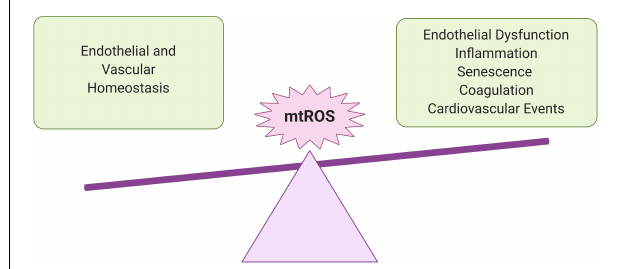
FIGURE 2 | Importance of redox balance in ECs. Understanding the potential impact of SARS-CoV-2 infection on EC mtROS levels is crucial for predicting adverse cardiovascular and pulmonary events in recovered COVID-19 patients. At lower levels, mtROS are essential for maintaining endothelial homeostasis and regulating immune responses to infection and other environmental stresses. However, in excess, they can promote chronic inflammation and endothelial dysfunction, persistently increasing risk for vascular